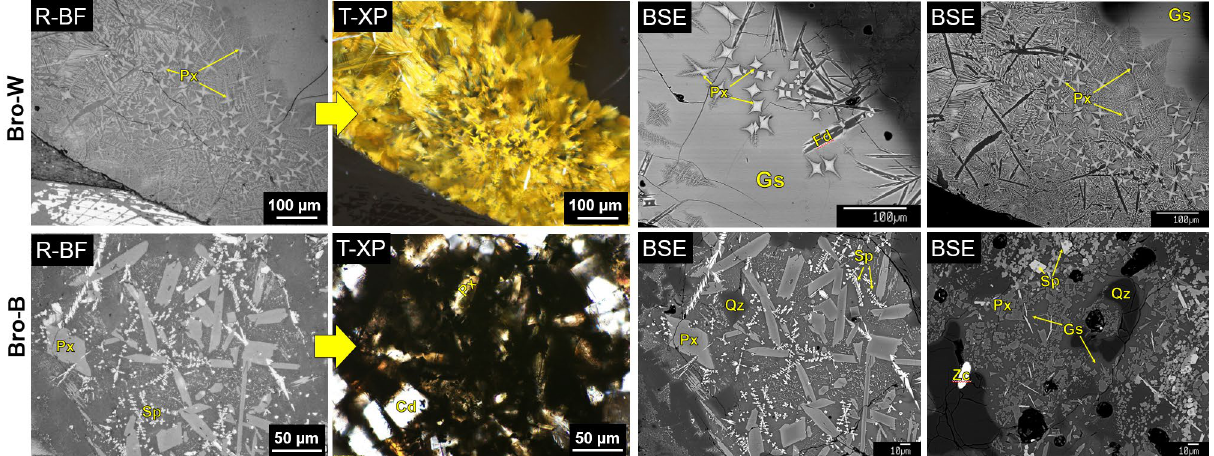
Figure 2. Typical microstructural features of archaeological samples Bro-W (top) and Bro-B (bottom). Reflected light bright-field (R-BF) and transmitted light cross polarized (T-XP) optical and scanning electron microscopy (BSE). Shows pyroxene (Px), spinel (Sp), cordierite (Cd), quartz (Qz), feldspar (Fd), and zircon (Zc) as well as glass (Gs).